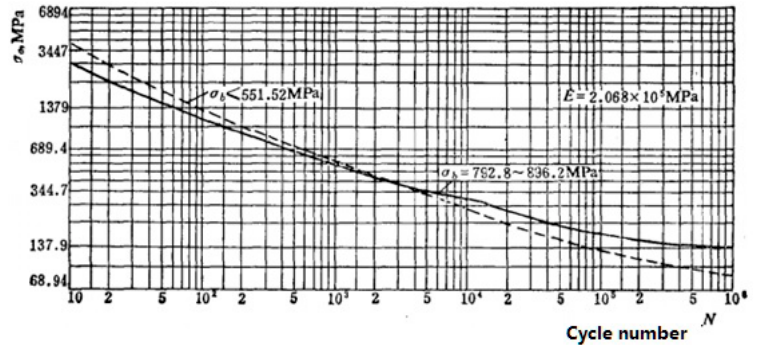
Figure 18. ASME fatigue design curve.